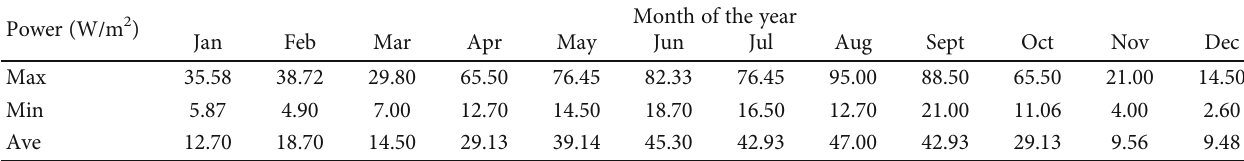
Table 3: Power distribution at 10 m height at the site.